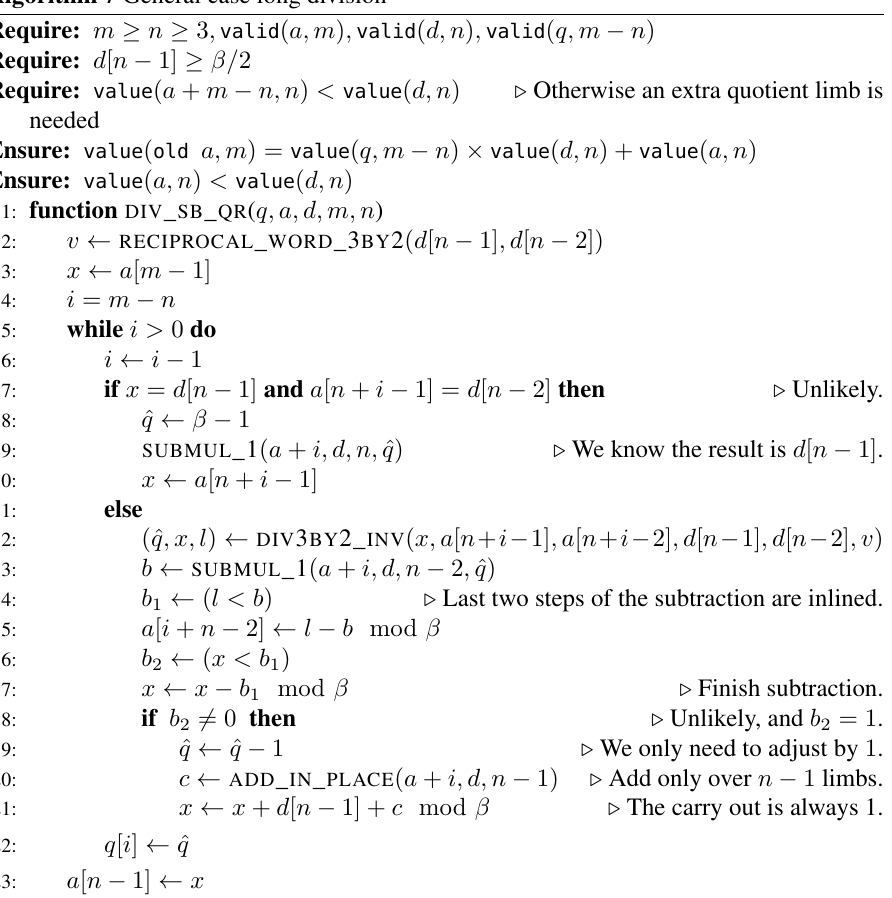
Algorithm 7 General case long